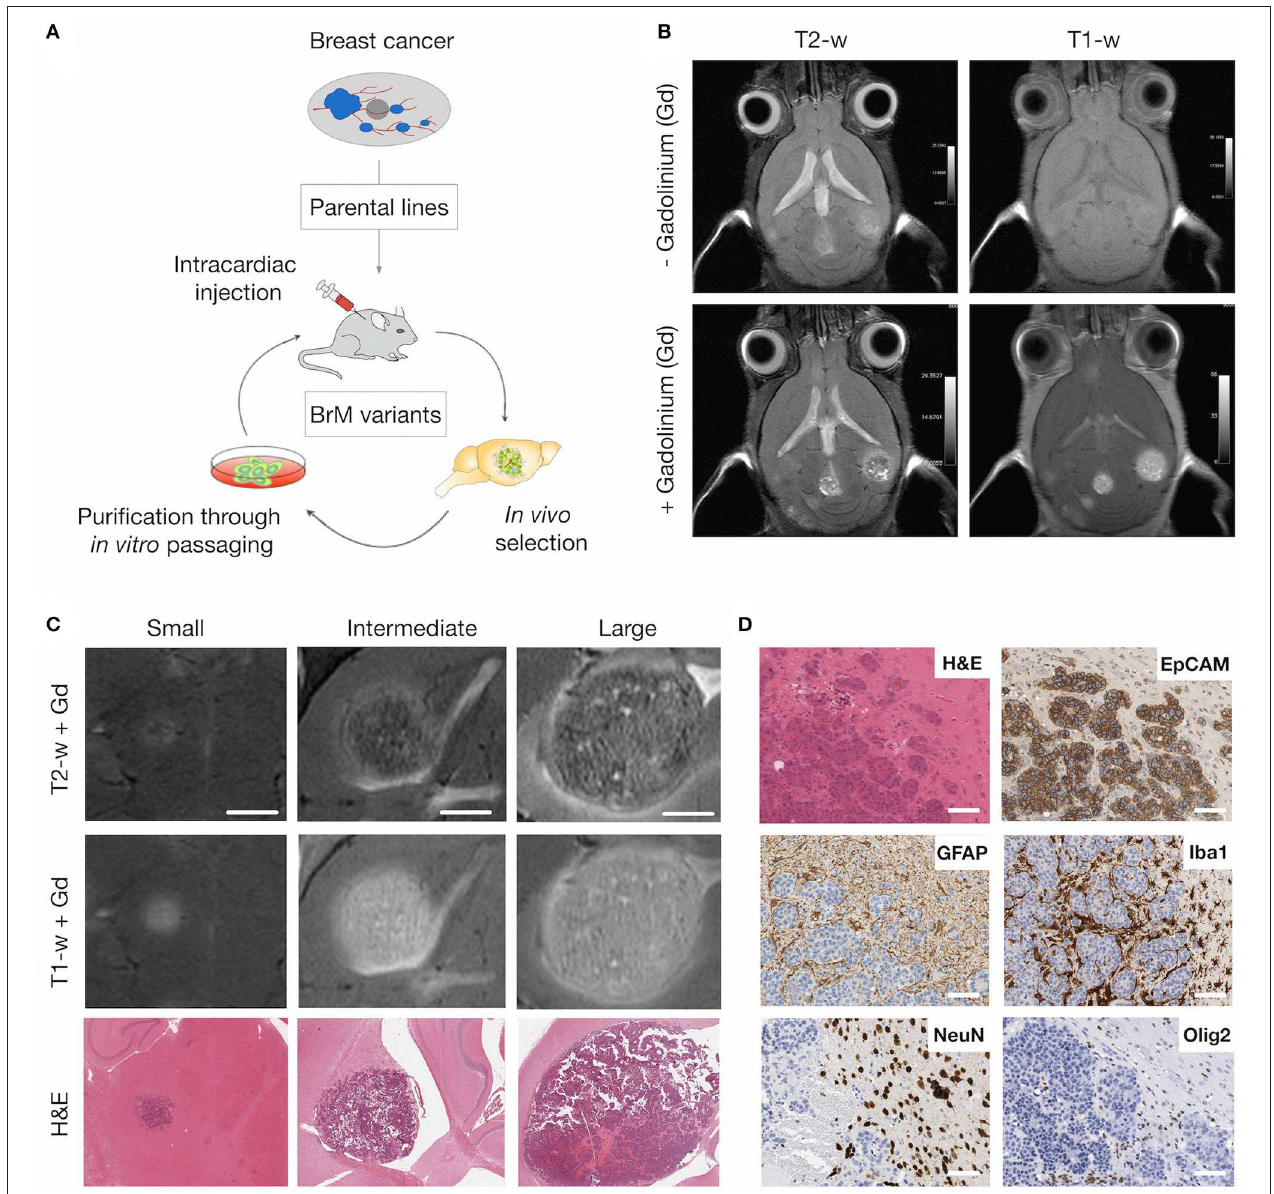
FIGURE 1 | MRI of brain metastatic lesions in the 99LN-BrM model. (A) Schematic depicting the selection of brain metastatic variants derived from parental cell lines through multiple rounds of in vivo selection following intra-cardiac injection. (B) Representative MR images of T1- and T2-weighted sequences with and without contrast enhancement. (C) Representative MR images and H&E stained sections for different stages of tumor progression (small, intermediate, and large BrM). Scale bar indicates 1.5mm. (D) Representative images of brain metastasis-associated stromal reactions. Tumor cells stained for the epithelial cell marker EpCAM, astrocytes, macrophages/microglia, neurons and oligodendrocytes are detected by GFAP, Iba1, NeuN, and Olig2 expression, respectively. Scale bars indicate 100 µ m.